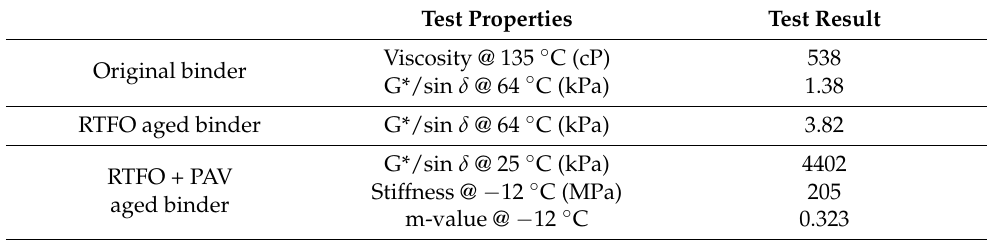
Table 1. Properties of base asphalt binder (PG 64–22).